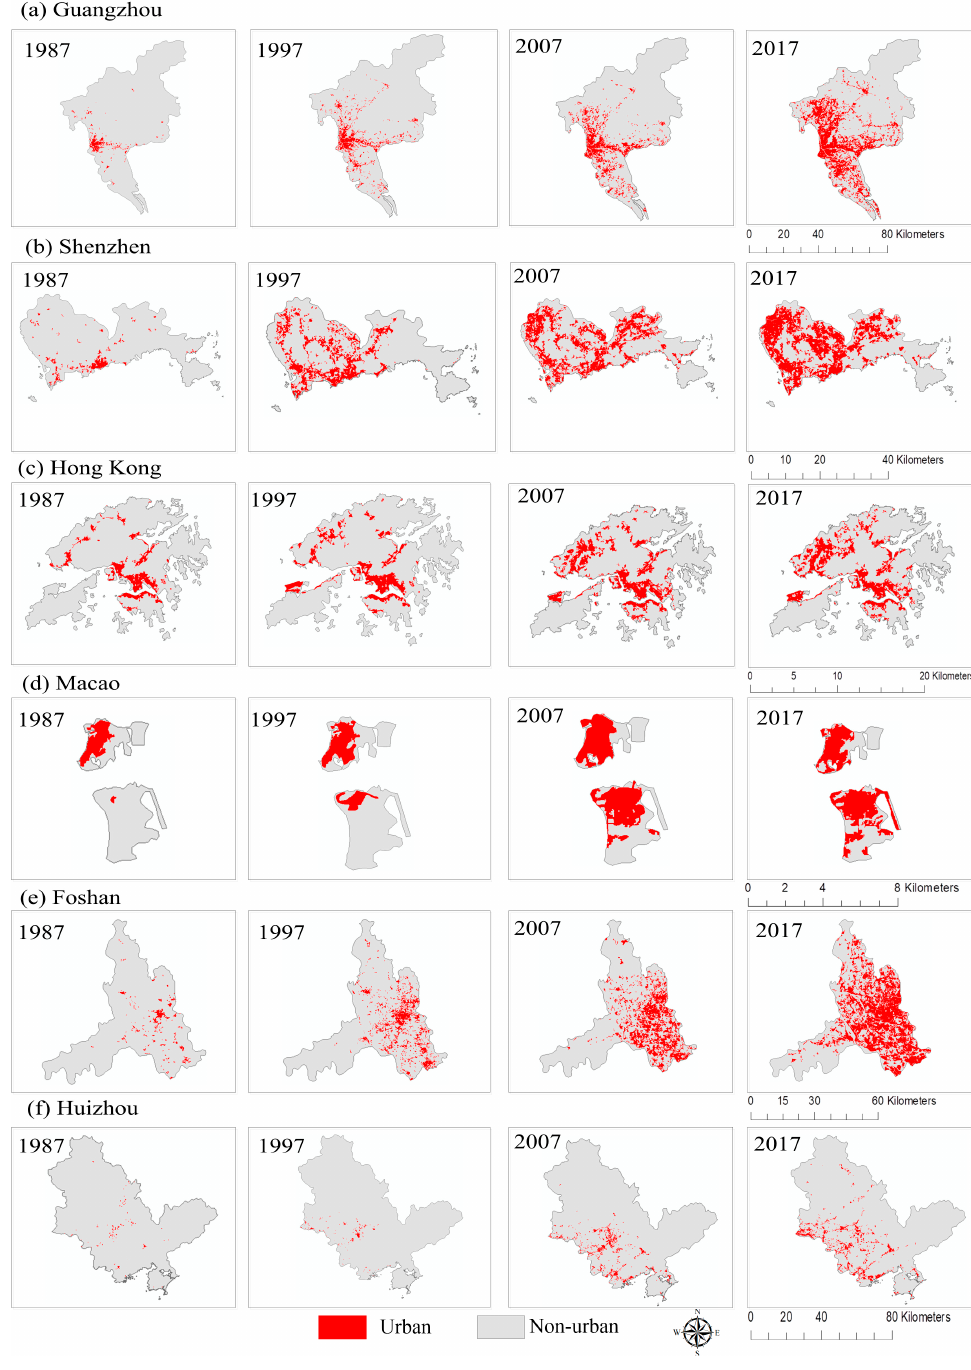
Figure 3. The urban areas of 11 cities within the Greater Bay Area (GBA) from 1987 to 2017. Figure 3. Cont